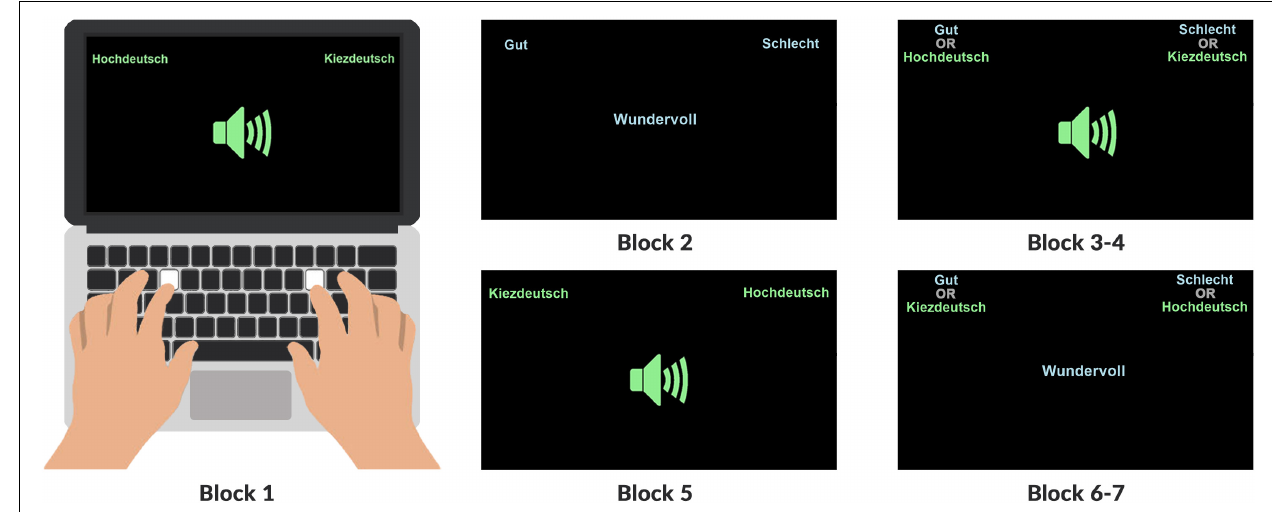
FIGURE 2 | Overview of the order of blocks showing the attribute categories Gut (good) and Schlecht (bad) in blue and the concept categories Hochdeutsch and Kiezdeutsch in green in their respective corners. Written and audio stimuli were presented in the middle of the screen. TABLE 2 | Overview and order of tasks in the IAT experiments for test order v1. Block